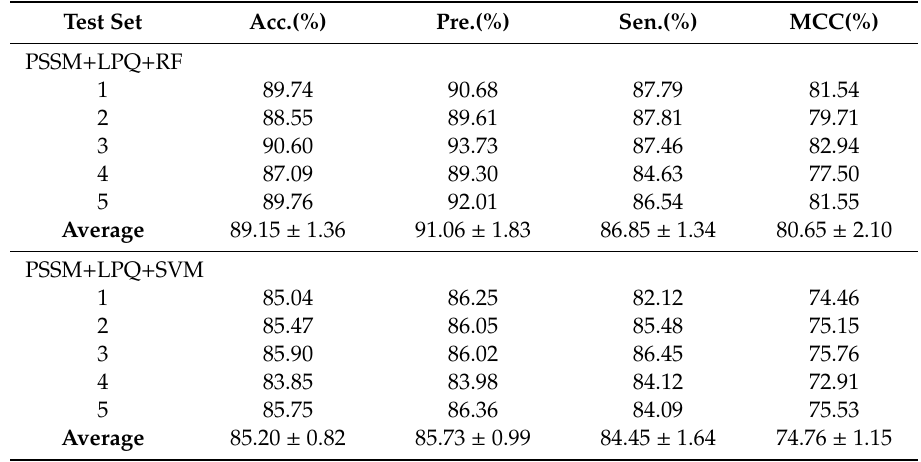
Figure 4. The ROC curves are generated by our method on nuclear receptor dataset.